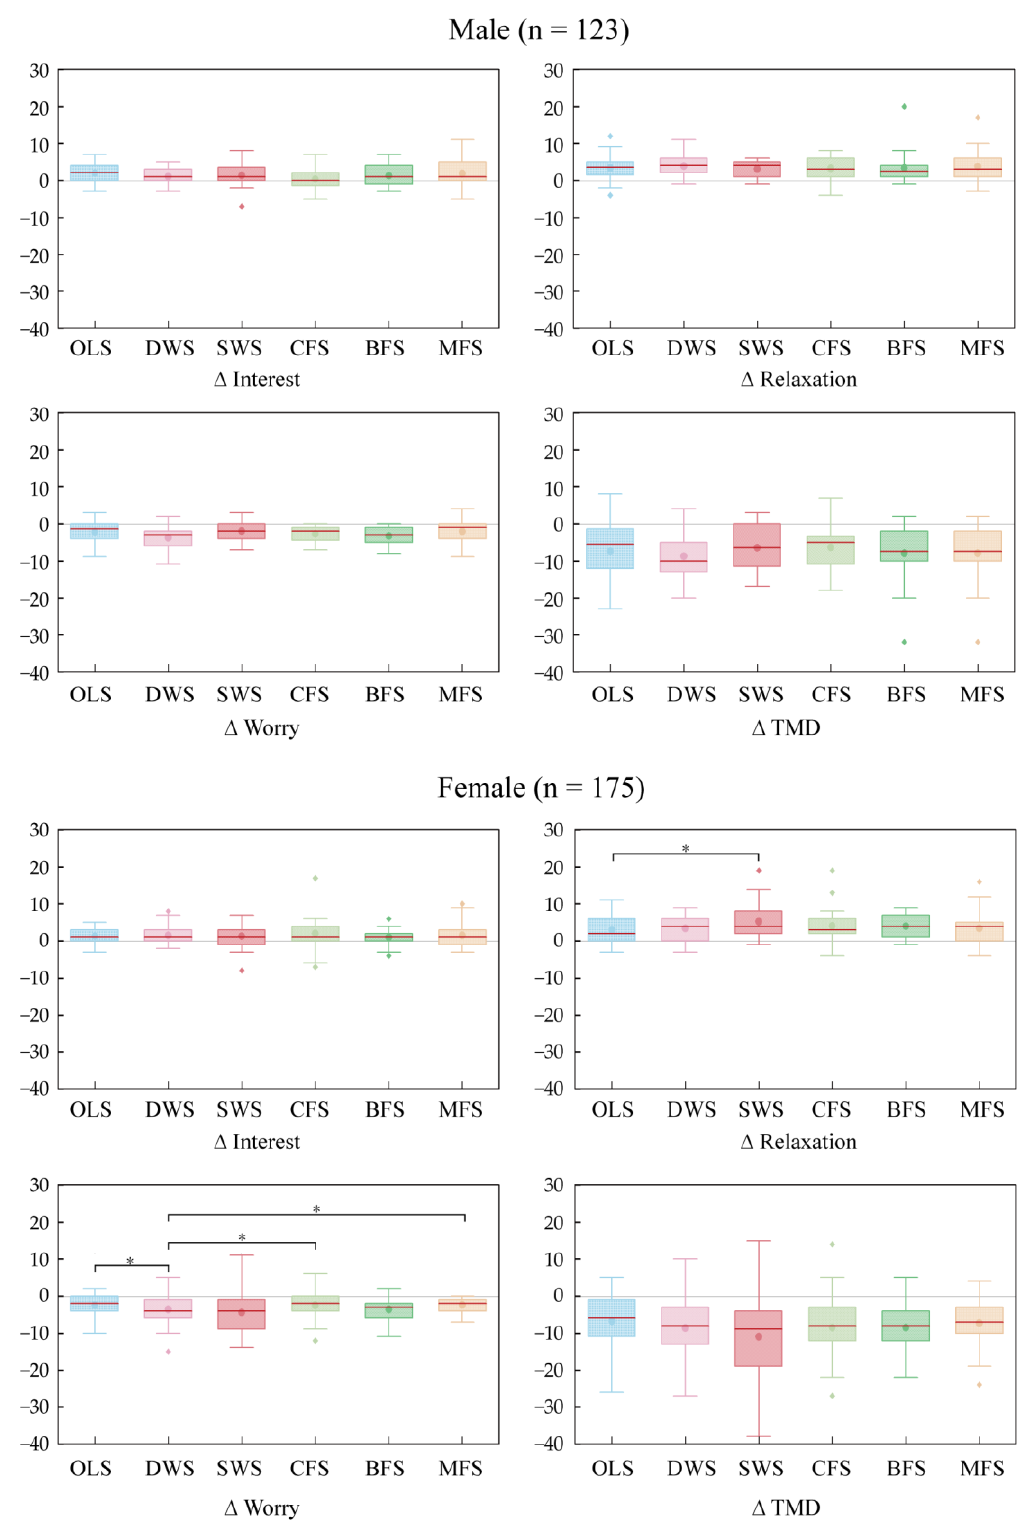
Figure 5. Differences in participants’ emotional response changes in different forest landscape spaces. * p < 0.05. OLS: overlook of the landscape space ( n = 49); DWS: dynamic water landscape space ( n = 48); SWS: static water landscape space ( n = 51); CFS: coniferous forest landscape space ( n = 50); BFS: broadleaf forest landscape space ( n = 51); MFS: mixed forest landscape space ( n = 49).